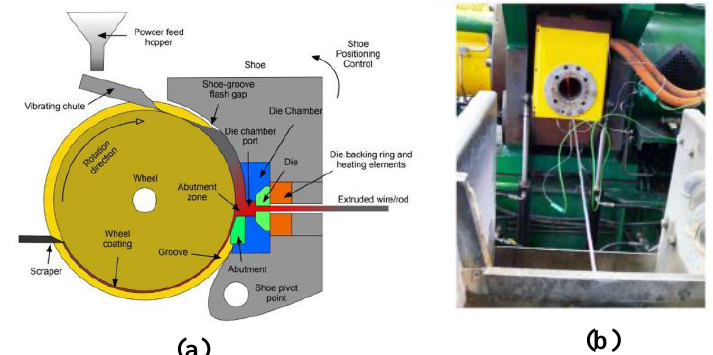
Figure 1. ( a ) Scheme of the Conform machine. ( b ) Extruded wire exiting from the Conform machine and entering the water trough for quenching [15].